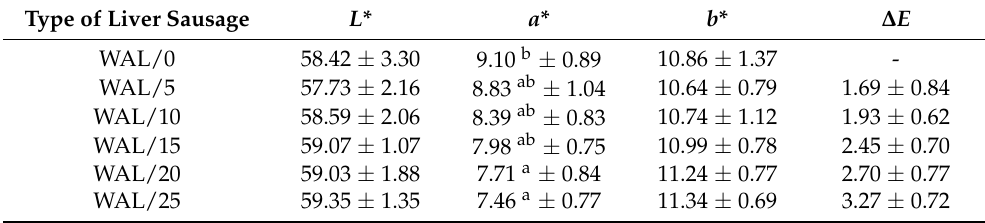
Table 4. Color components and ∆ E of the liver sausages (mean value ± standard deviation), n = 4. Type of Liver Sausage L * a